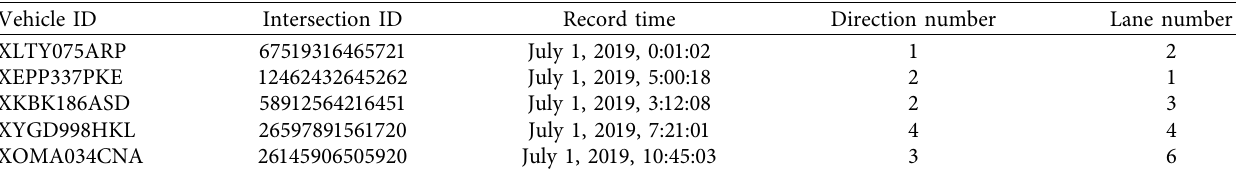
Table 1: Row data sample.